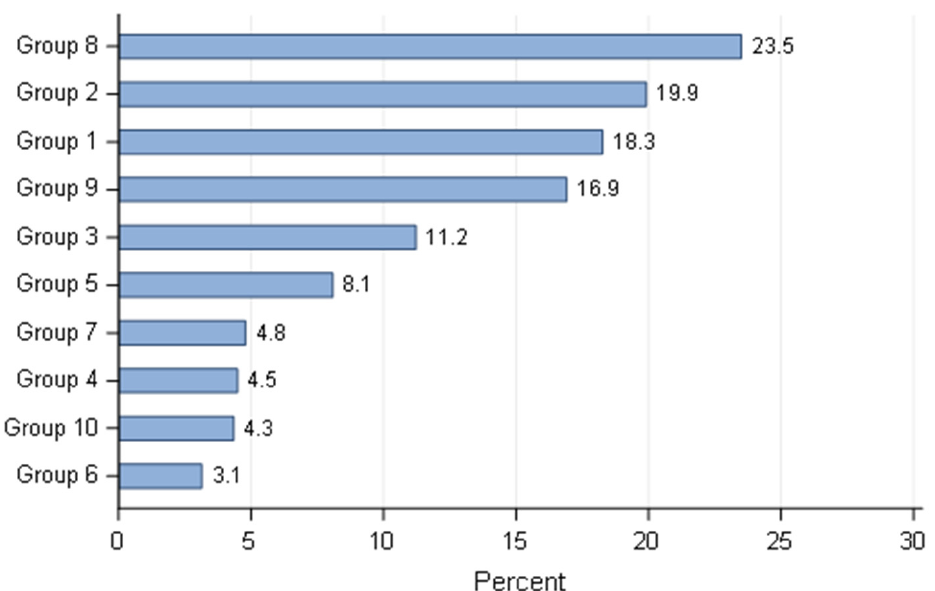
Figure 3. Overall distribution based on different groups according to the classification of the Feder- ation Cynologique Internationale (FCI-www.fci.be (accessed on 4 June 2021) (multiple answers were possible)—all responders ( n = 668).